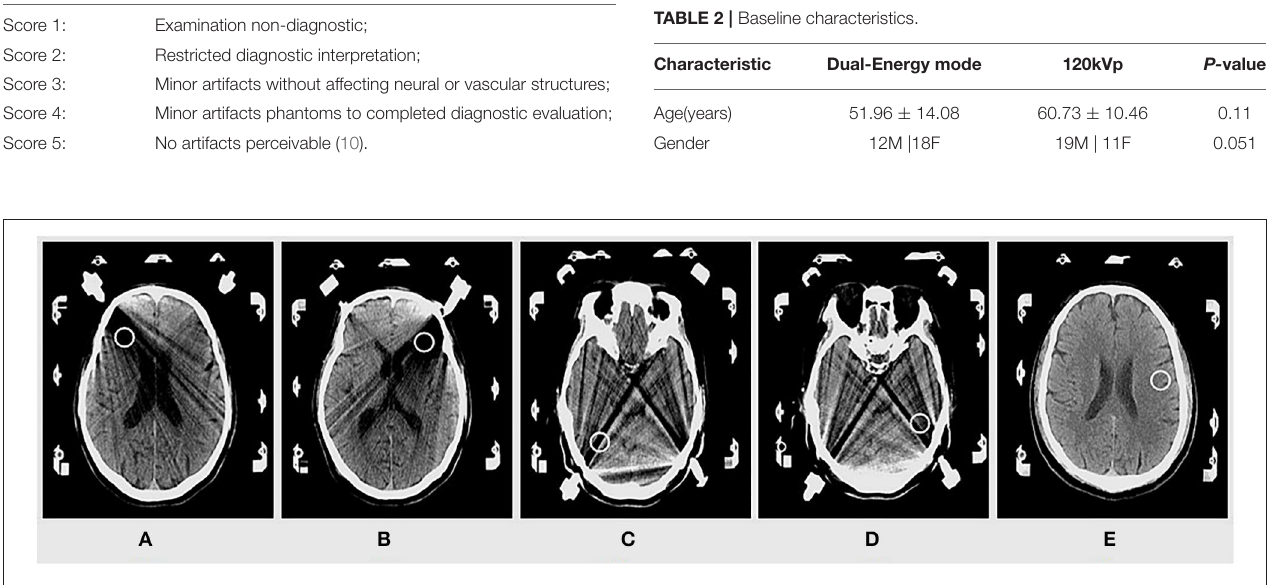
Frontiers in Radiology |